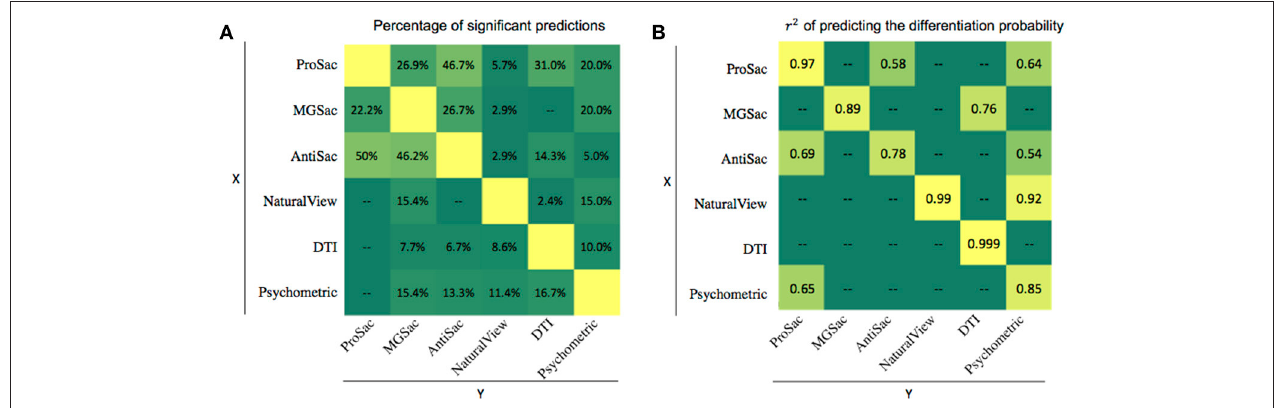
FIGURE 3 | Multilinear regression results. (A) Ratio (in percentage) of significant features of one assessment predicted by another. (B) r 2 of predicting the differentiation probability of one assessment from